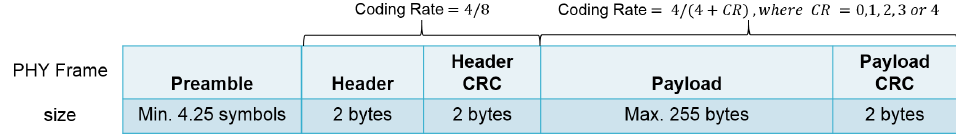
Figure 1. LoRa PHY frame